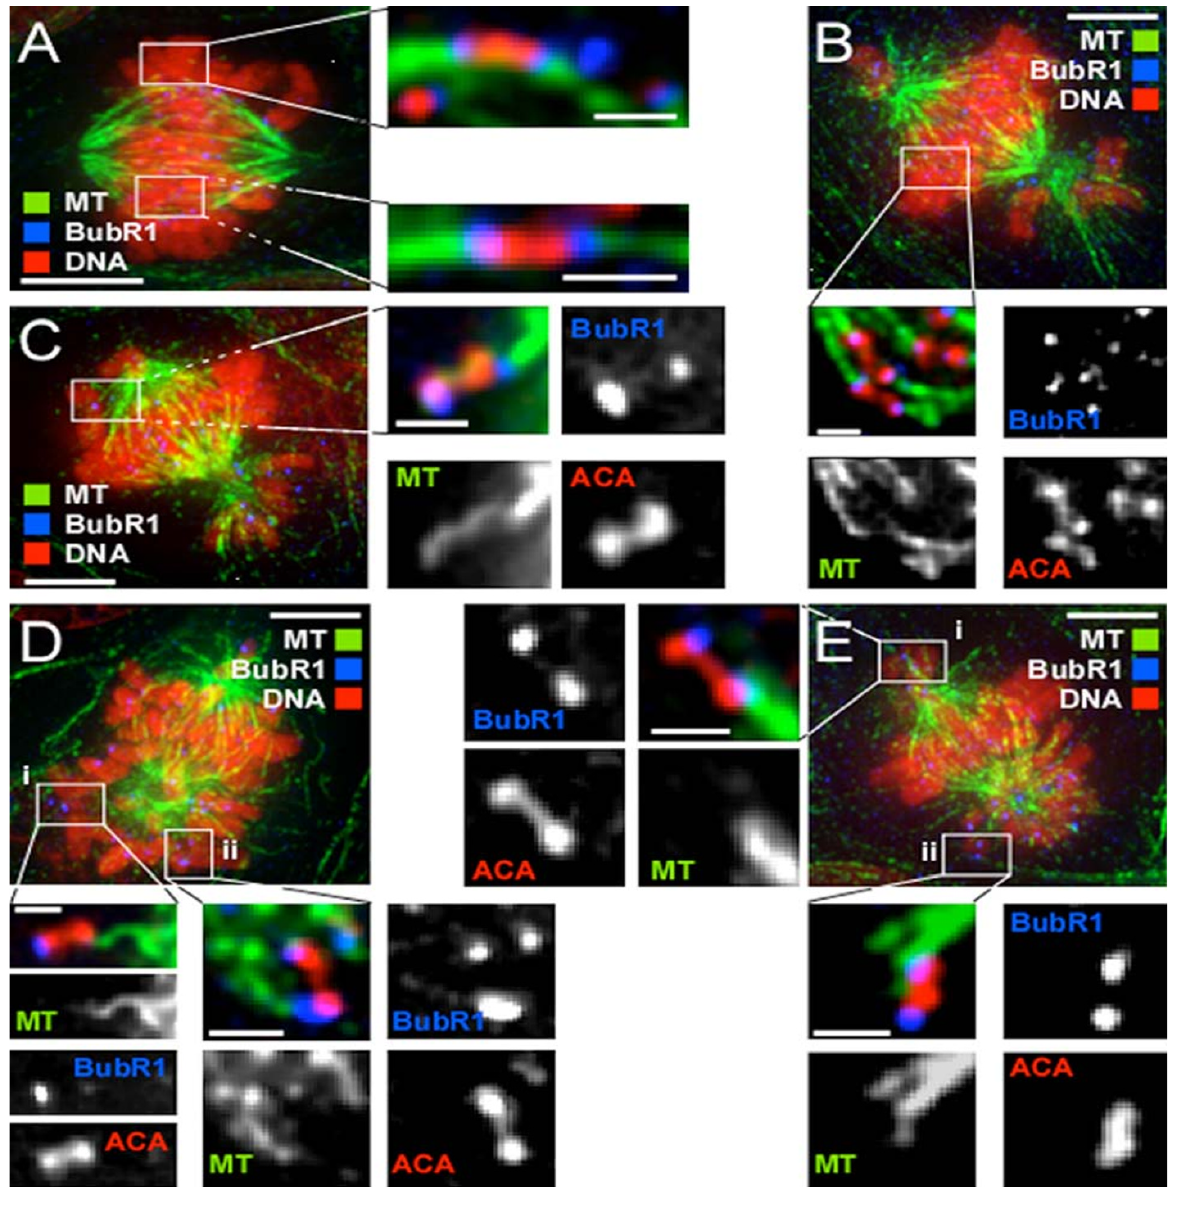
Figure 5 GSK-3 inhibitors yield monopolar and syntelic attachments . DLD-1 cells were incubated with GSK-3 inhibitors for 24 hours then fixed and stained to detect DNA (red), tubulin (green), BubR1 (blue) and centromeres (ACA, red) as indicated. Images represent projections of deconvolved image stacks. ( A ) Control cell showing examples of bioriented chromosomes. ( B ) GSK-3 inhibitor treated cell showing that chromosomes near the metaphase plate are bioriented. ( C-E ) Inhibitor treated cells showing examples of either syntelic attachments (C, Dii, Eii) or monopolar attachments (Di, Ei). Bar is 5 µ m when the entire spindle is shown or 1 µ m in the enlargements. The cells in C-E were treated with 30 µ M